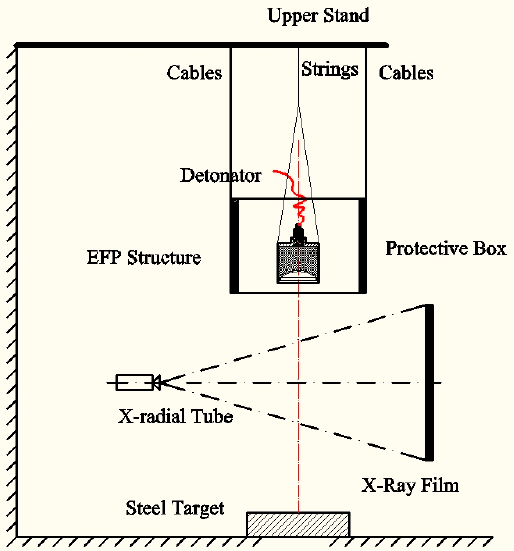
Figure 2. Schematic diagrams of the flash X-ray experiment of a typical EFP.